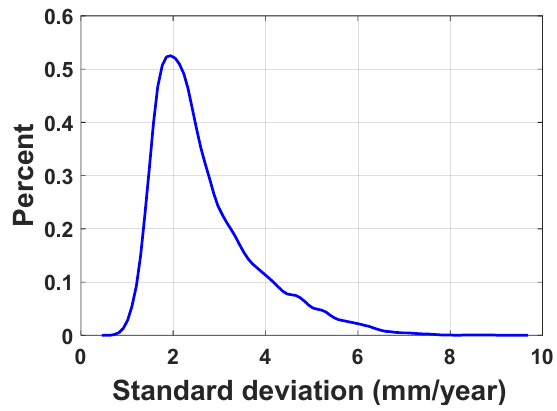
Figure 5. Probability density function of standard deviation of average subsidence